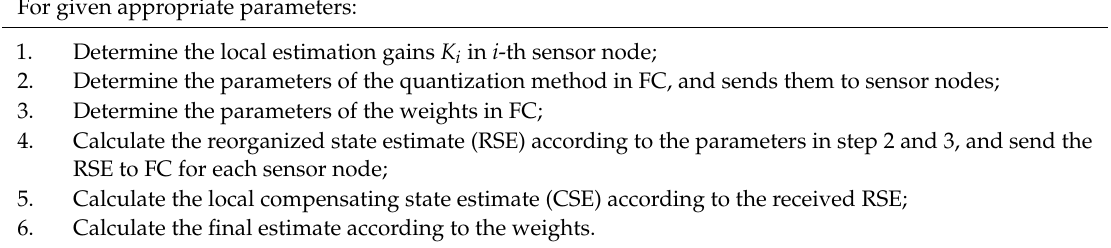
Table 1. The computation procedures of